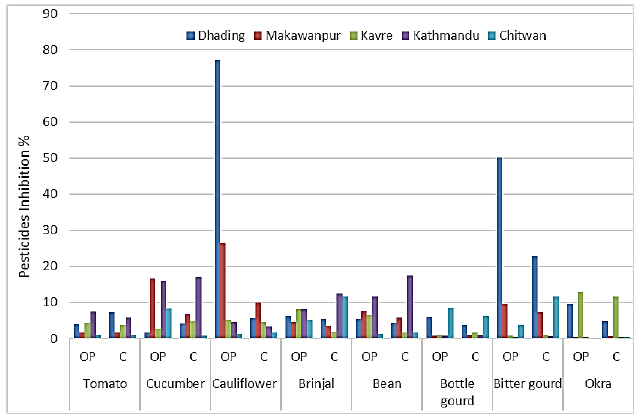
Figure 1: Vegetables from different districts with OP and